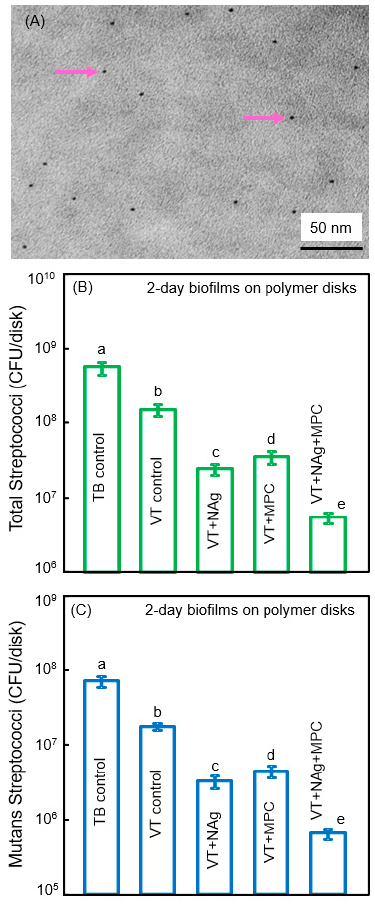
Figure 5. Combining nanoparticles of silver (NAg) with MPC. ( A ) Representative TEM image of NAg (arrows) in resin. The particle size for NAg (mean ± SD; n = 100) was (2.7 ± 0.6) nm; ( B , C ) Colony-forming units (cfu) of 2-day biofilms on cement with total streptococci and ( C ) mutans streptococci (mean ± SD; n = 6). cfu on VT + 0.1% NAg + 3% MPC were 2 logs lower than TB control. In each plot, values with dissimilar letters are significantly different ( p < 0.05). (Reproduced with permission from [70]. Elsevier, 2015)